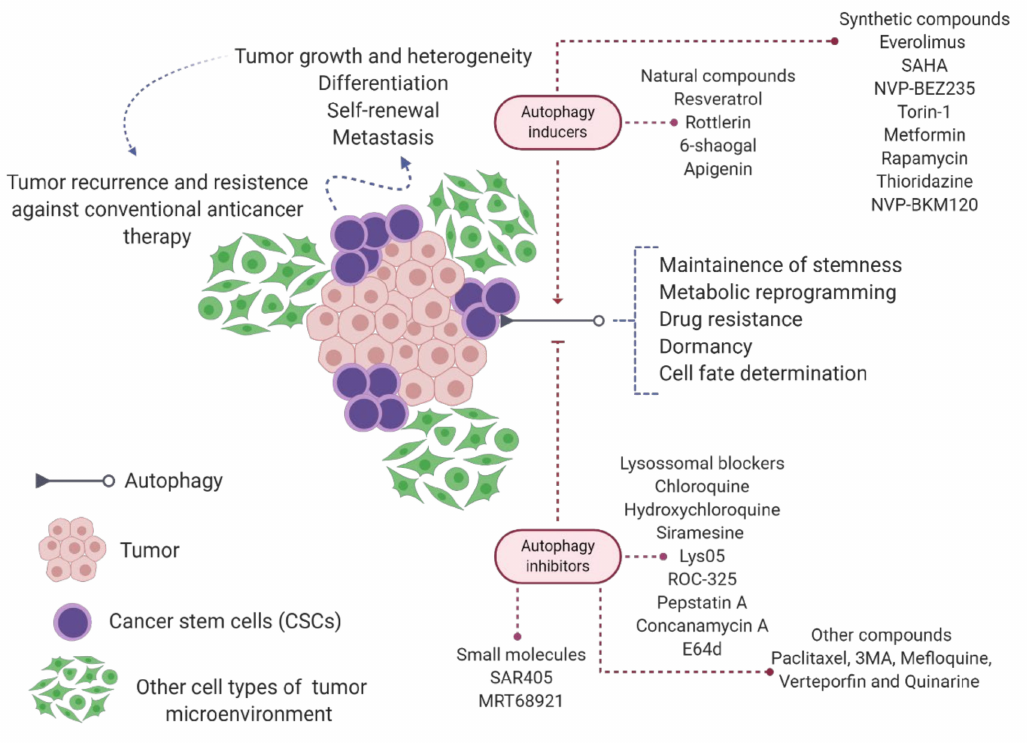
Figure 6. The role of autophagy in cancer stem